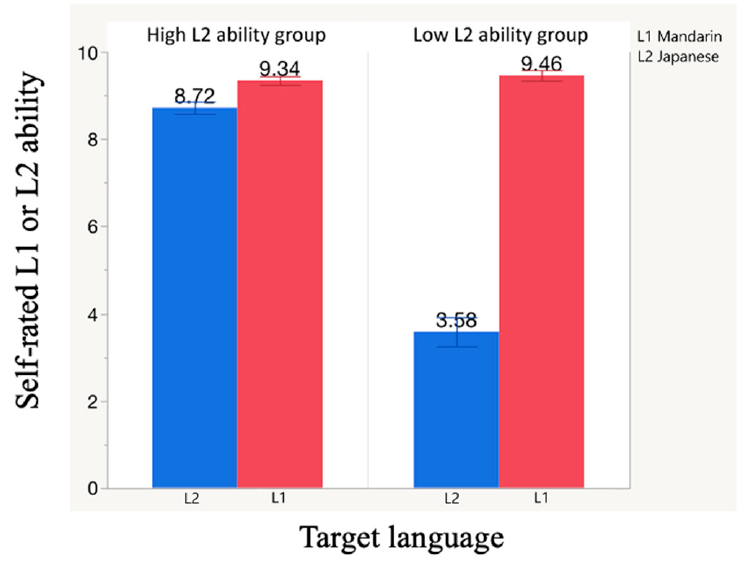
Figure 4. Self-rated L1 and L2 ability of native speakers of Mandarin (L1) who speak Japanese (L2).